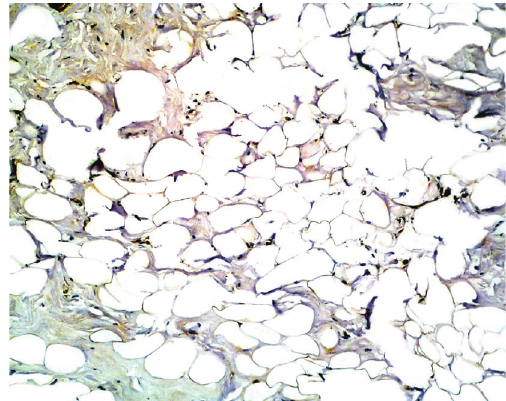
Figure 8: Normal breast. This figure presents the fat tissue from the IDC patient at a morphologically normal site away from the lesions which showed no reaction to anti-NUCKS antibody. ABC method, Magnification 200x.